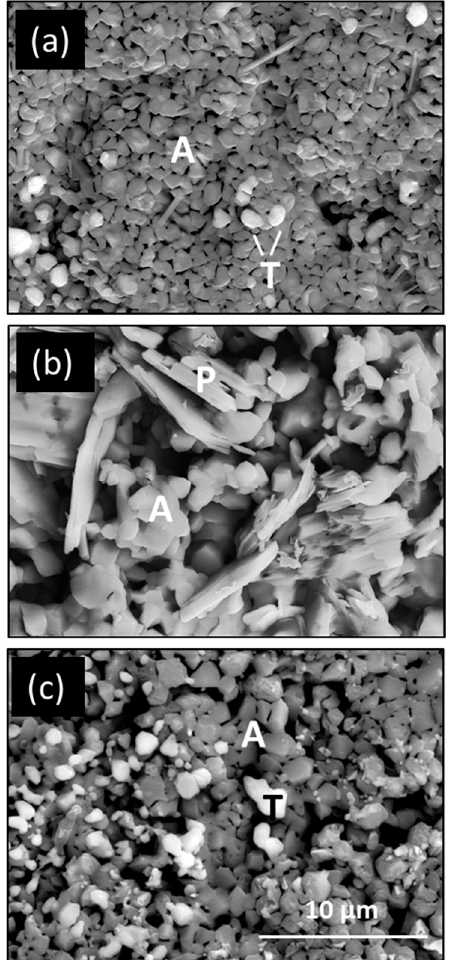
Figure 7. SEM / BSE surface microstructures of scales formed on Ti 2 AlC at 1300 ◦ C in Mach 0.3 high Figure 7. SEM/BSE surface microstructures of scales formed on Ti 2 AlC at 1300 °C in Mach 0.3 high velocity burner rig (500 h at 1300 ◦ C) Uncoated backside at sample ( a ) top, ( b ) hot center, ( c ) grip end. T velocity burner rig (500 h at 1300 °C) Uncoated backside at sample ( a ) top, ( b ) hot center, ( c ) grip end. (Ti-rich transient scale); A (Al 2 O 3 ); P (etched platelets) T (Ti-rich transient scale); A (Al 2 O 3 ); P (etched platelets) [15].